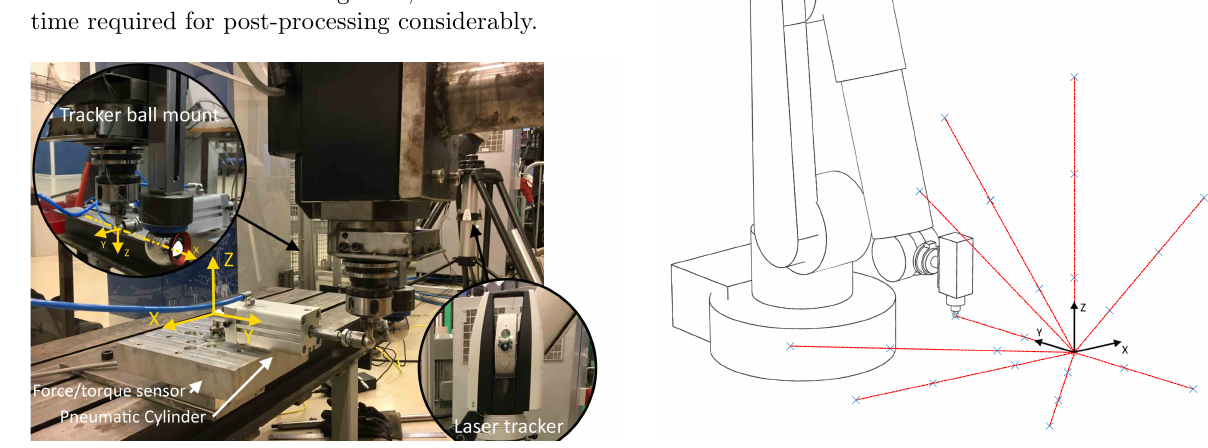
Figure 13: 6-DOF Industrial Robot: position of robot relative to centre of ball joint connected to force